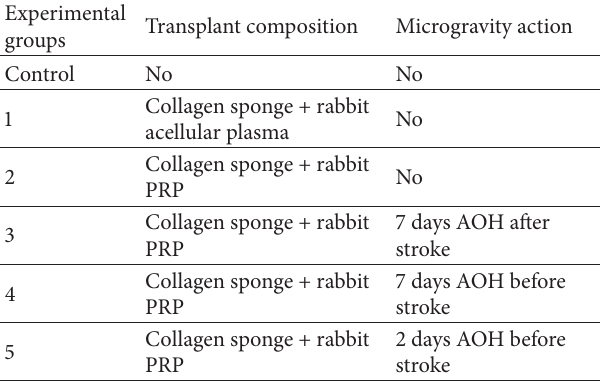
Table 1: Characteristics of experimental